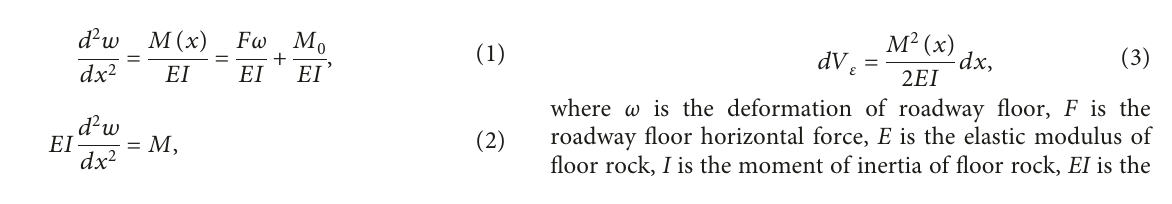
Figure 7: Deformation and failure of roadway-surrounding rock. (a) Roof. (b) Roadway side. (c) Floor. (d)